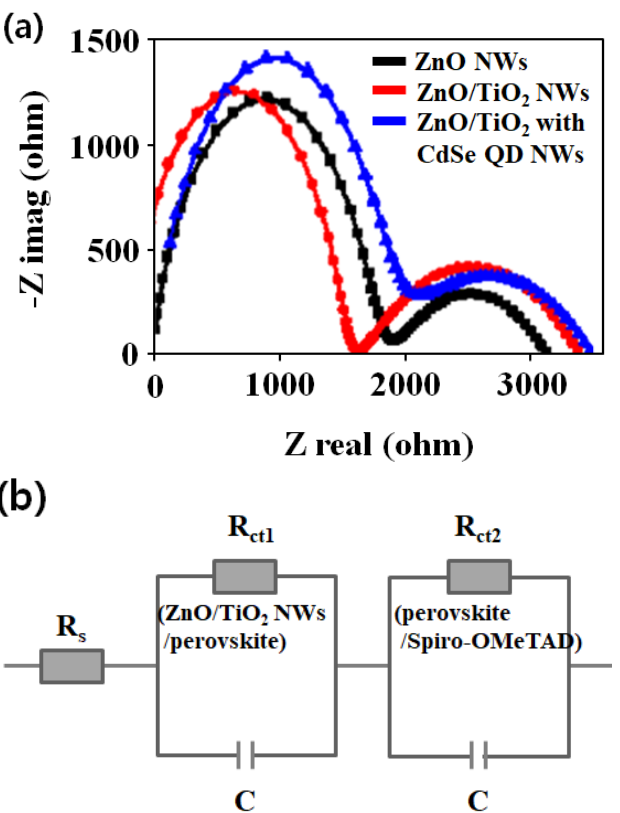
Figure 4. ( a ) Nyquist plots of PSCs based on ZnO / TiO 2 core / shell arrays with AgCl-doped CdSe quantum dots. ( b ) The equivalent circuit diagram used to fit data.